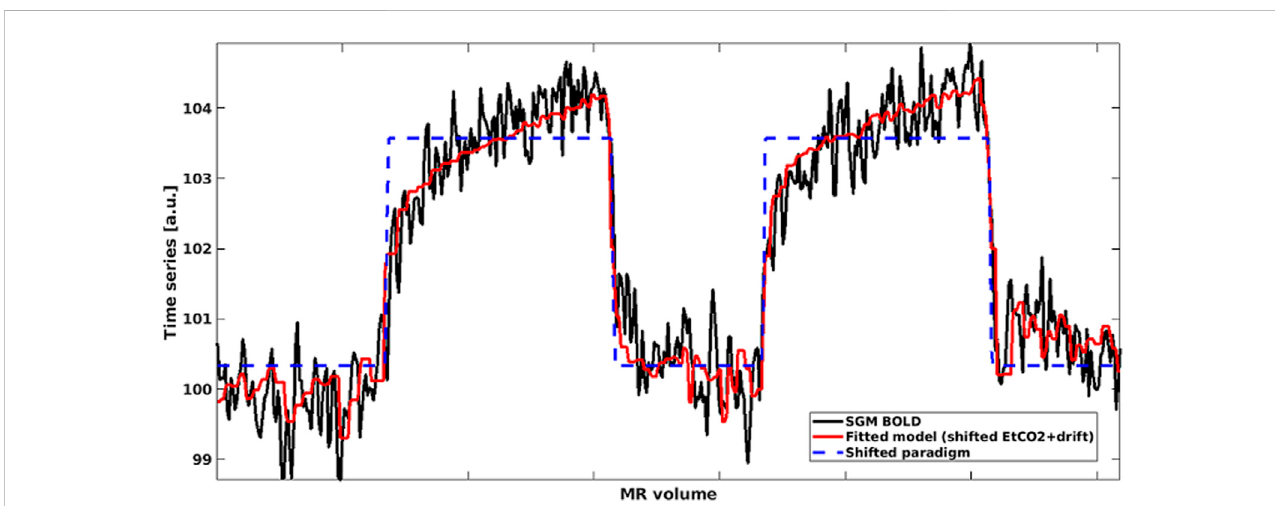
FIGURE 1 Mean BOLD time series in SGM (black) modelled using shifted EtCO 2 and linear drift term (red). The shifted rescaled paradigm is shown in blue: High values correspond to hypercapnia periods whereas low values correspond to normocapnia periods. (SGM, Subcortical grey matter; EtCO 2 , End-tidal CO 2